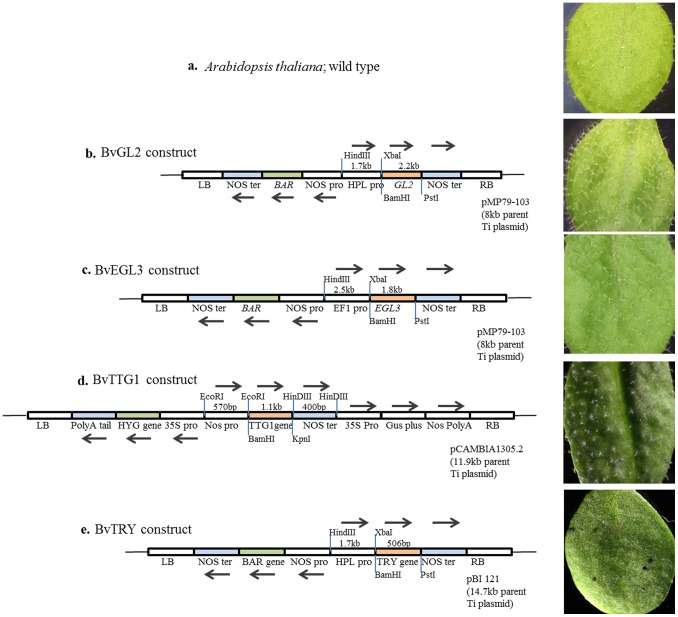
Trichome phenotypes of Arabidopsis transgenic plants overexpressing trichome related genes from Brassica villosa.a. Expanded leaf of wild type Arabidopsis (Columbia) showing normal trichome pattern. b. BvGL2 over-expressed transgenic leaf showing increased trichome number. c. BvEGL3 over-expressed transgenic leaf showing increased trichome number. d. BvTTG1 over-expressed transgenic leaf showing increased trichome number. e. BvTRY over-expressed transgenic leaf showing glabrous phenotype. (All photographs were taken with 10X magnification by a compound microscope at 3 weeks after germination).